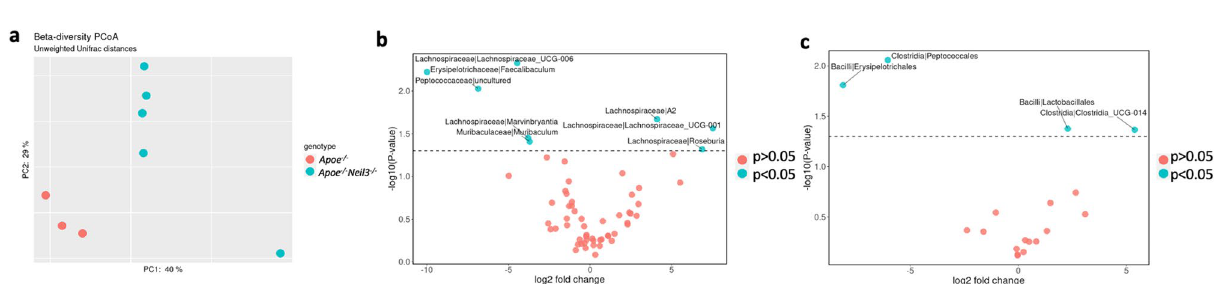
Figure 2. Different levels of plasma metabolites in Apoe −/− Neil3 −/− mice as compared to Apoe −/− mice. ( a ) Volcano plot displaying plasma metabolites differentially expressed between Apoe −/− Neil3 −/− and Apoe −/− mice. The log2 fold change of each individual metabolite is represented on the x-axis. The y-axis corresponds to the − log10 of the p value. The dashed lines indicate the cutoff for p value (0.05) and fold change (twofold), and significant metabolites are presented as green dots. ( b ) Top 10 significant metabolites in Apoe −/− Neil3 −/− as compared to Apoe −/− mice, ordered by p value. hMPP: 3-(3-hydroxyphenyl) propionate. FC: fold change. Two- way ANOVA, n = 5.